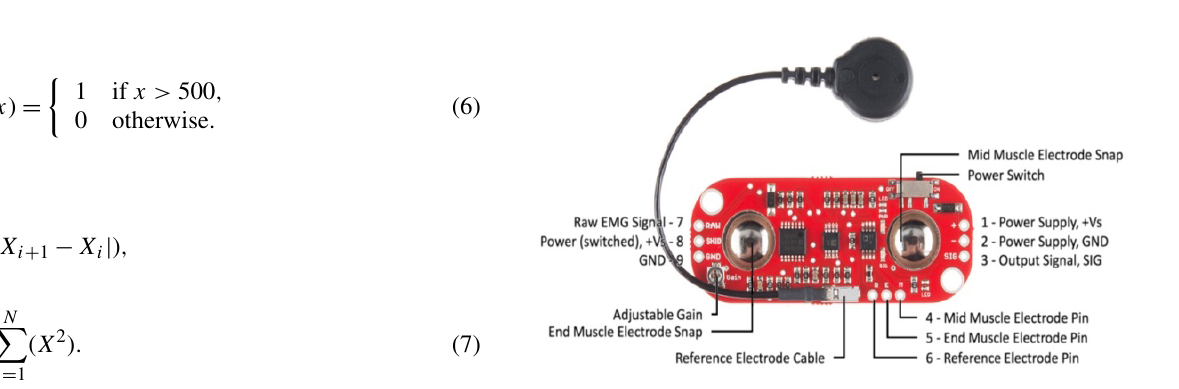
Figure 6. (a) Signals obtained from the arm during hand close and open, (b) thumb signal, and (c) signals from four fingers.